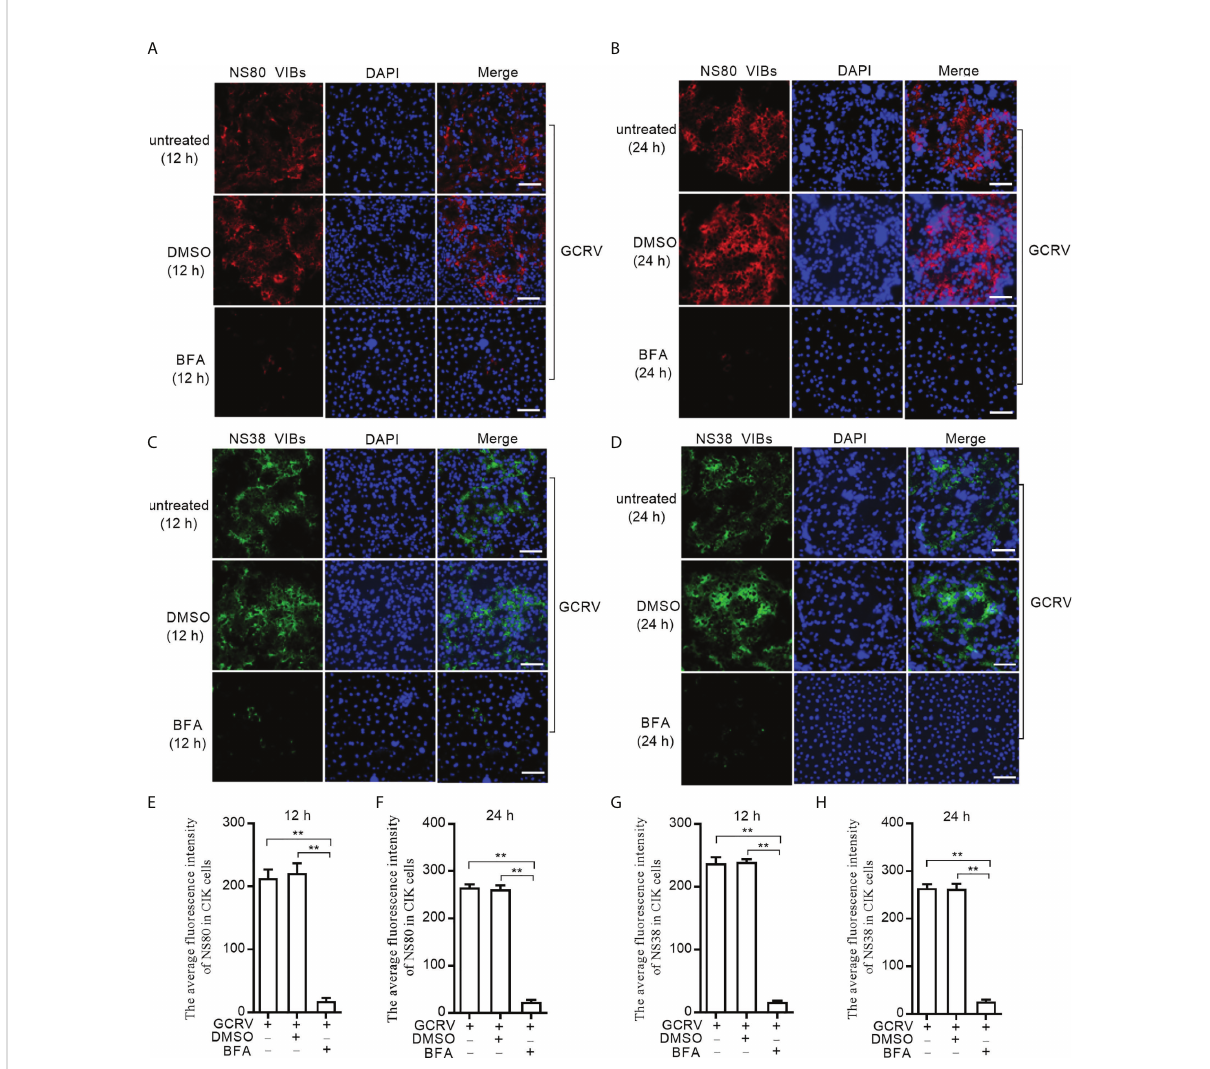
FIGURE 4 BFA treatment reduces the numbers of viral inclusion bodies. (A) Immuno fl uorescence analysis for NS80 in CIK cells that were treated with DMSO or BFA for 12 h or left untreated. Scale bars, 50 µm. (B) Immuno fl uorescence analysis for NS80 in CIK cells that were treated with DMSO or BFA for 24 h or left untreated. Scale bars, 50 µm. (C) Immuno fl uorescence analysis for NS38 in CIK cells that were treated with DMSO or BFA for 12 h or left untreated. Scale bars, 50 µm. (D) Immuno fl uorescence analysis for NS38 in CIK cells that were treated with DMSO or BFA for 24 h or left untreated. Scale bars, 50 µm. (E) The average fl uorescence intensity of NS80 in CIK cells that were treated with DMSO or BFA for 12 h or left untreated. (F) The average fl uorescence intensity of NS80 in CIK cells that were treated with DMSO or BFA for 24 h or left untreated. (G) The average fl uorescence intensity of NS38 in CIK cells that were treated with DMSO or BFA for 12 h or left untreated. (H) The average fl uorescence intensity of NS38 in CIK cells that were treated with DMSO or BFA for 24 h or left untreated. Means ± SEM (n=3) are shown in (E-H) . Data were tested for statistical signi fi cance. The asterisk above the bracket indicated statistical signi fi cance between the two groups connected by the bracket. ** p <